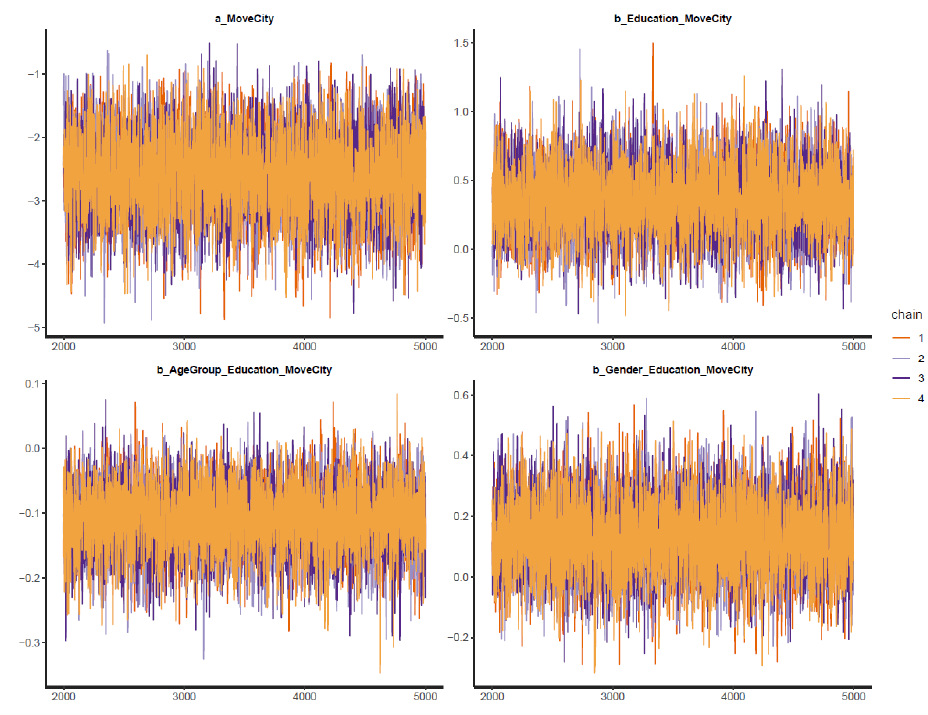
Figure 3. Trace plots for Model 1′s posterior parameters.